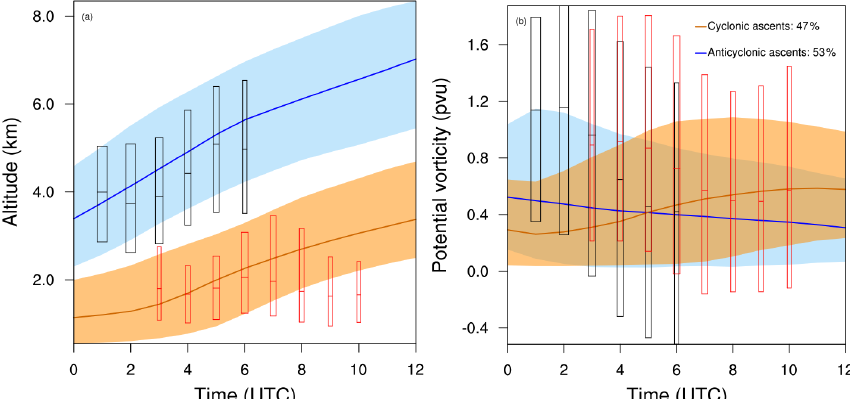
Figure 7. Time evolution of (a) altitude (in kilometers) and (b) PV (in PVU) between 00:00 and 12:00UTC along the selected trajectories in REF. The median (colored bold line) and the 25th–75th percentiles (shading) are shown for cyclonic (orange) and anticyclonic (blue) ascents. The median and the 25th–75th percentiles are shown with box plots for the 2h rapid cyclonic (red) and anticyclonic (black) segments. Box plots are displayed only where the number of rapid segments lies above their time average, and their width is scaled with this